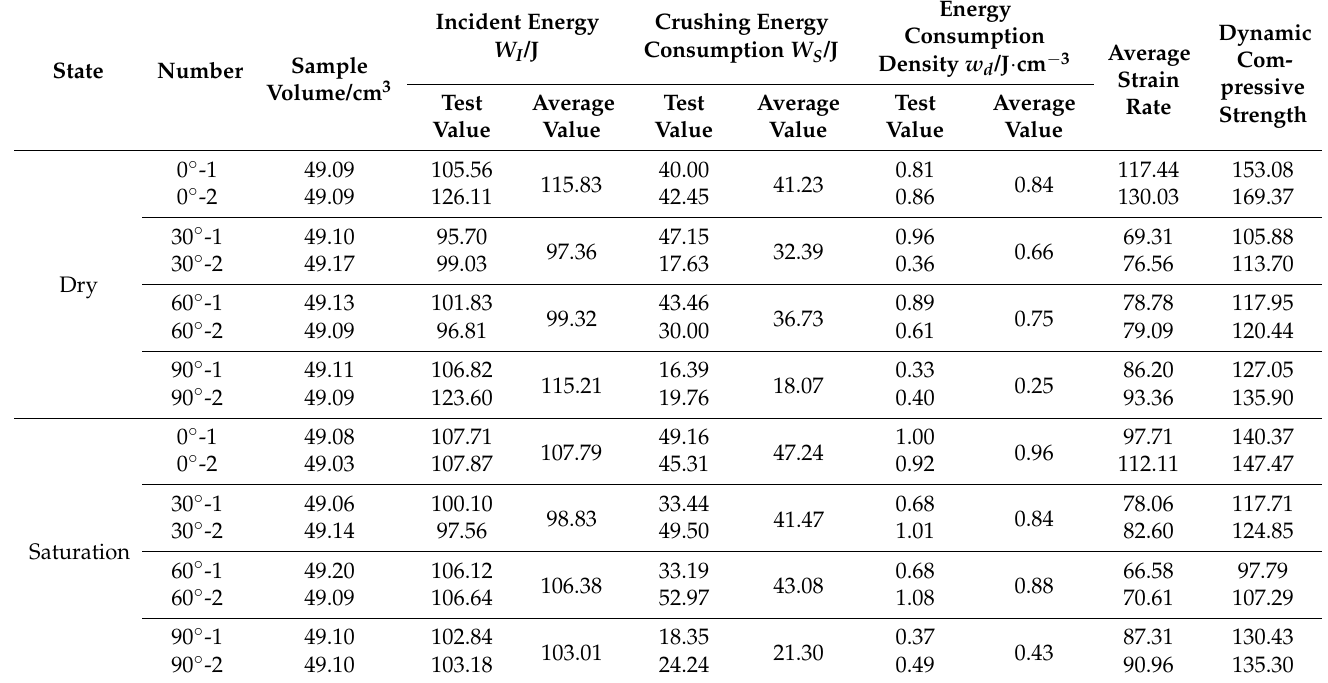
Table 1. Energy parameters of saturated phyllite samples with different stratification angles.